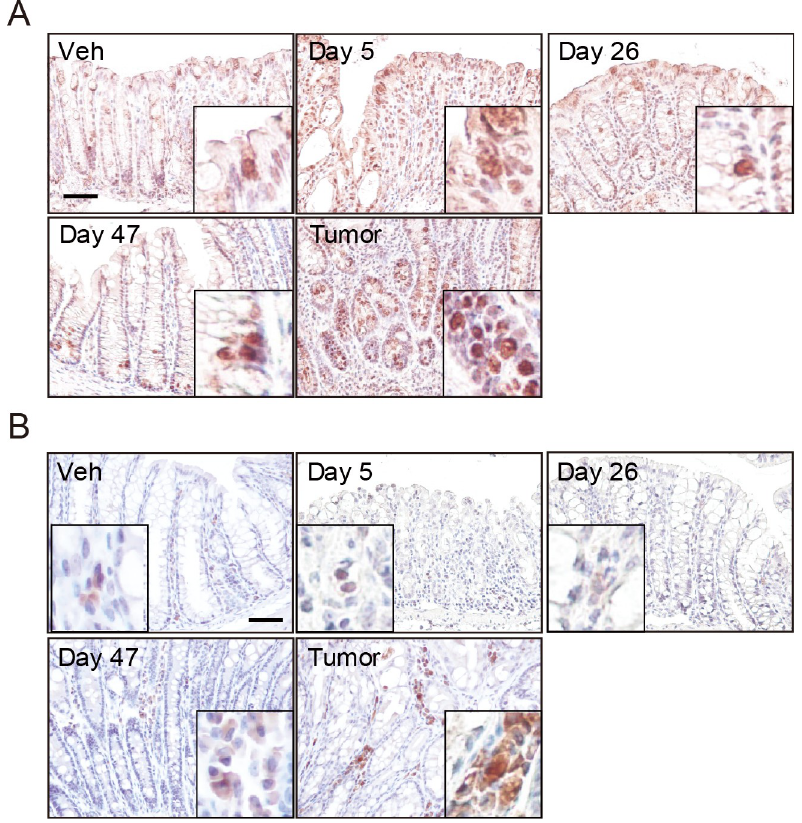
Fig 3. The colon expression of enzyme related lipid metabolite production. Representative images of immunohistochemistry of (A) COX-2 and (B) p22 phox . Areas surrounded by squares indicate COX-2 or p22 phox - positive cells. Scale bar, 50 μ